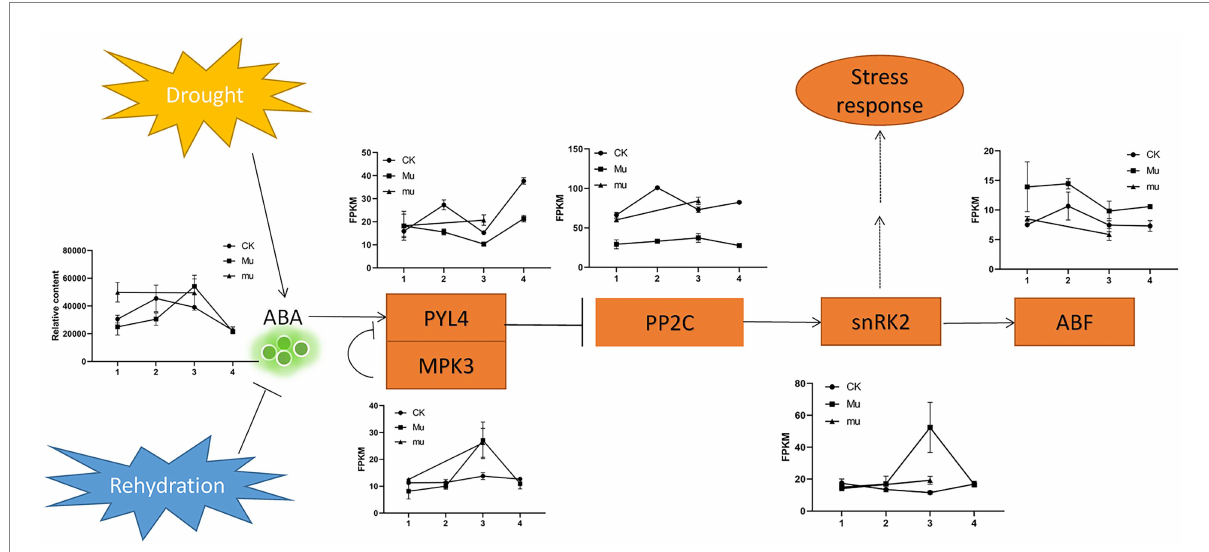
FIGURE 7 Expression pattern of DEGs involved in ABA signaling. PYL4, pyrabactin resistance 1-like 4; MPK3, mitogen protein kinase 3; PP2C, protein phosphatases 2C; snRK2, sucrose nonfermenting-1 (SNF1) related kinase 2; ABF, ABA-responsive element-binding factors. Rectangles indicate genes, Oval indicates biological process, arrows indicate promotion, bars (T) indicate inhibition, and dashed lines indicate postulated regulation.